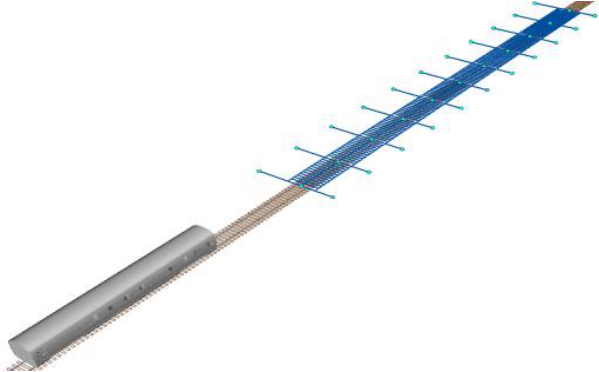
Figure 12. Train-track-overhead system model.